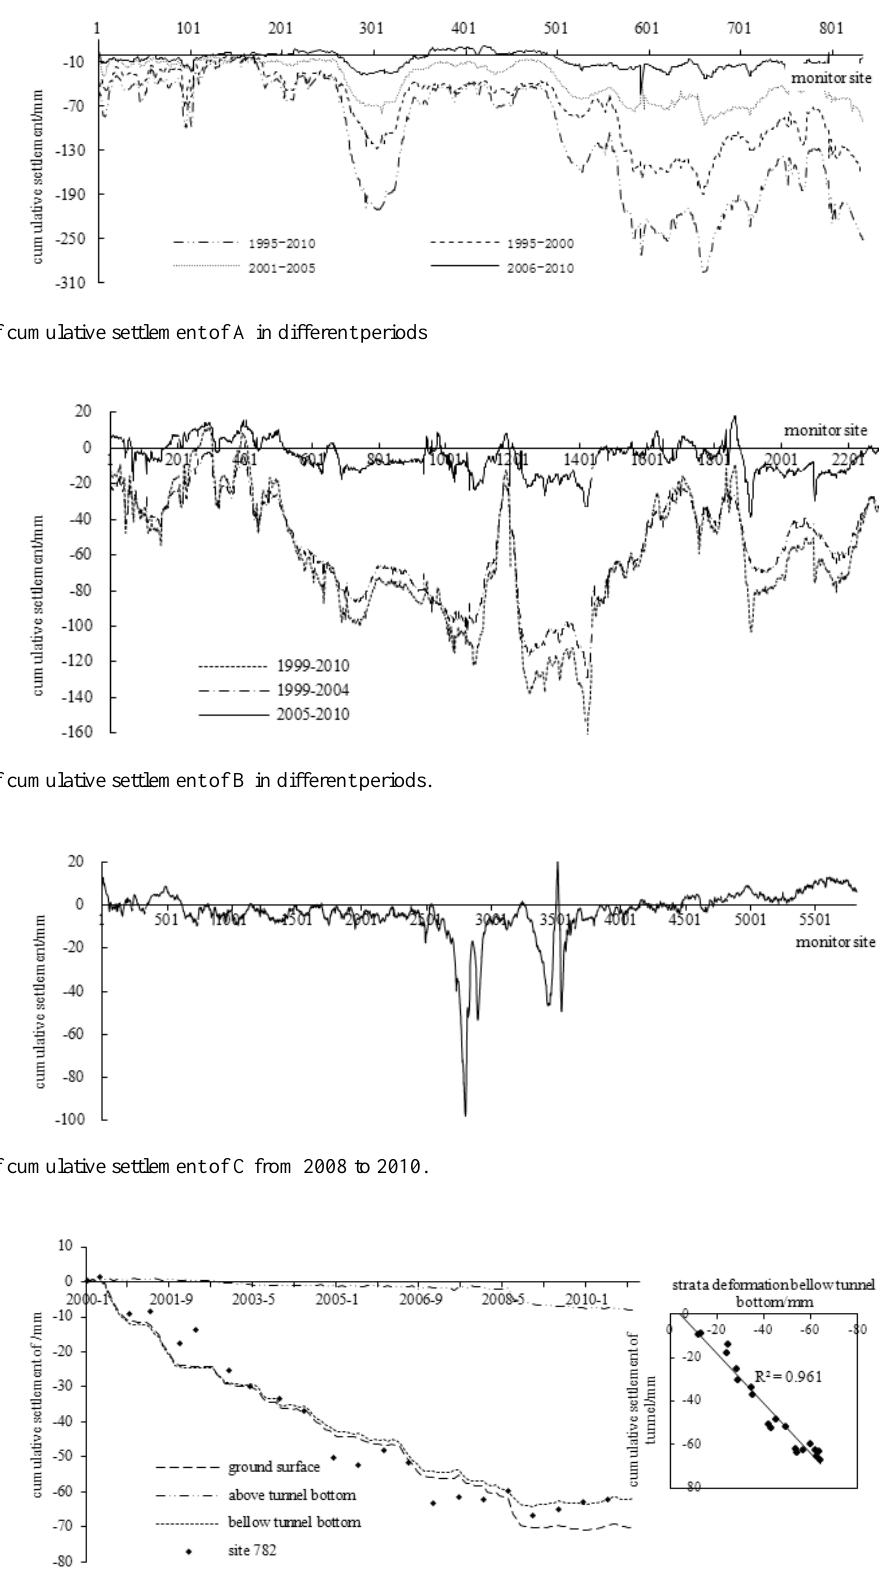
Figure 4. Contrast the monitoring results of point 782 with the ones of